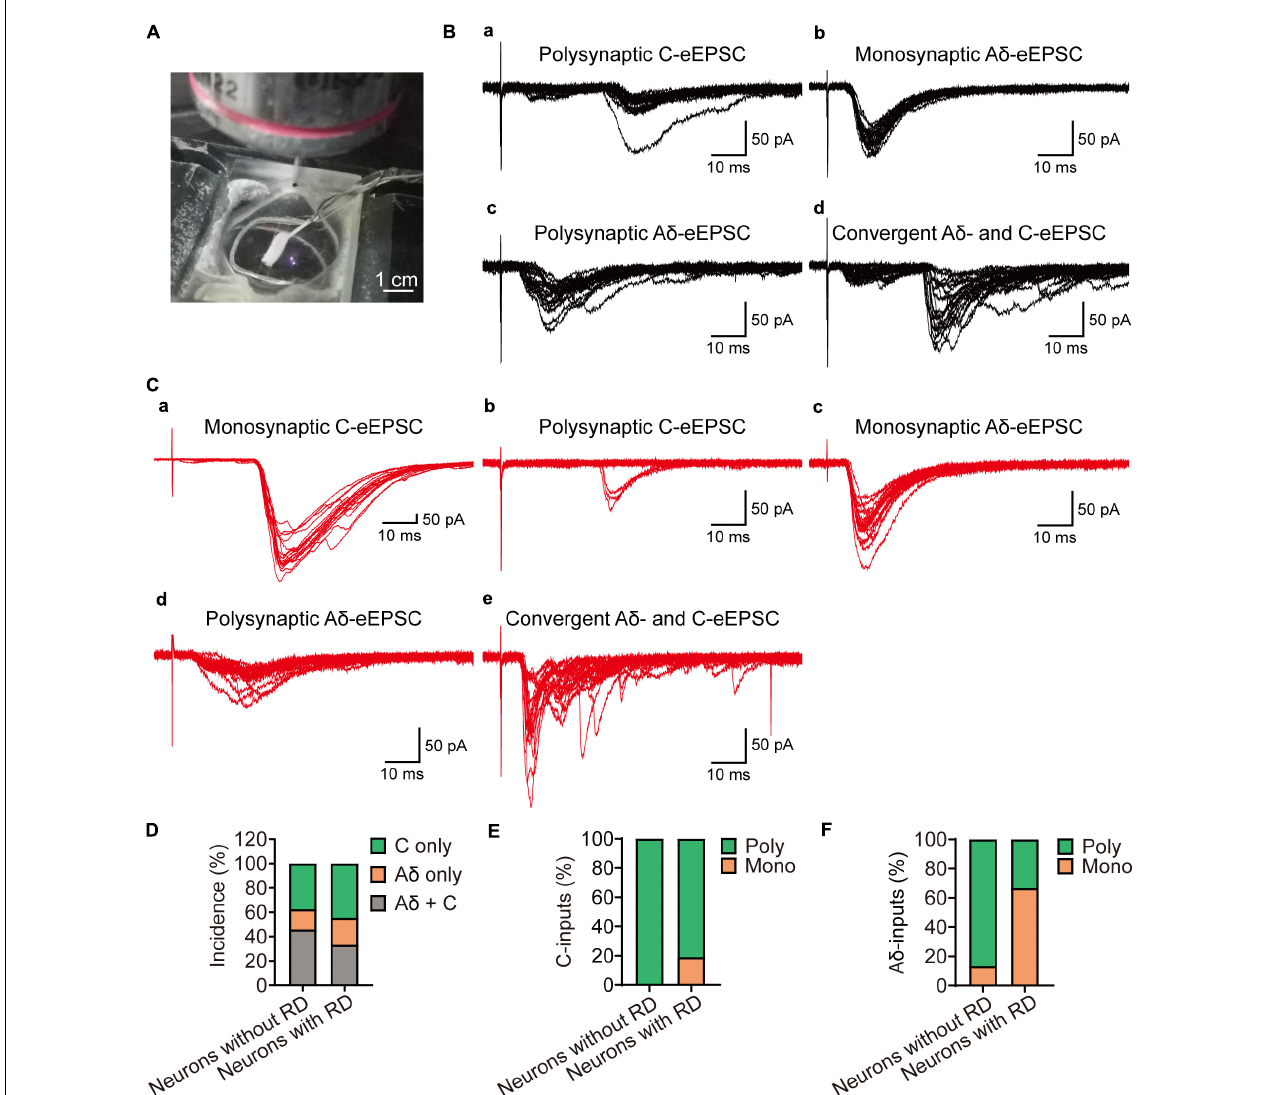
FIGURE 5 | Primary afferent innervation onto SG neurons with or without RD examined by dorsal root stimulation. (A) Exemplar image shows a customized suction electrode for the stimulation onto a DR that attached with a parasagittal spinal cord slice. (B) Representative traces of A δ - and C-fiber induced EPSCs of SG neurons without RD, evoked by high-frequency stimulation. (a) Polysynaptic C-fiber evoked eEPSC, (b) Monosynaptic A δ -fiber mediated eEPSC, (c) Polysynaptic A δ -fiber mediated eEPSC, (d) Convergent A δ - and C-fiber mediated inputs onto SG neurons without RD. (C) Representative traces of A δ - and C-fiber-evoked EPSCs recorded from SG neurons with RD. (a) Monosynaptic C-fiber evoked eEPSC, (b) Polysynaptic C-fiber evoked eEPSC, (c) Monosynaptic A δ -fiber mediated eEPSC, (d) Polysynaptic A δ -fiber mediated eEPSC, (e) Convergent A δ - and C-fiber mediated inputs onto SG neurons without RD. (D) Quantification of A δ - and C-fiber-induced eEPSCs onto SG neurons with or without RD by electrical stimuli. (E) Quantification of mono- and polysynaptic C-fiber mediated responses in different groups upon DR stimulation. (F) Quantification of mono- and polysynaptic A δ -fiber mediated responses in different groups upon DR stimulation. RD, rebound depolarization; DR, dorsal root; eEPSC, evoked excitatory postsynaptic current.